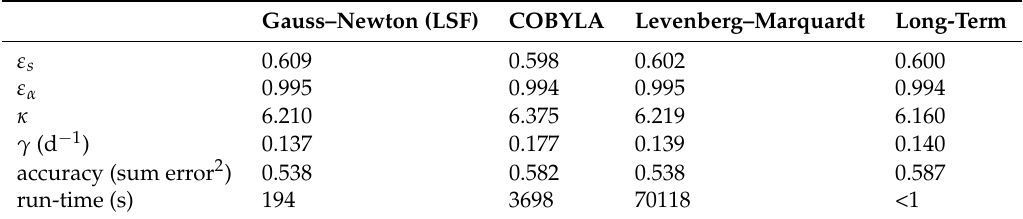
Table 3. Values of the parameters when fitted to the patient digitized data. The rightmost column has the values when the retrieved data points are fitted to the long-term approximation as in [57]. The left columns contain the fitted parameter values by our efficient methods. Except for the rightmost column, all methods are combined with the Rosenbrock numerical scheme. The fixed parameters have the values shown in Table 2. Run-time comparison is reported in seconds in the last